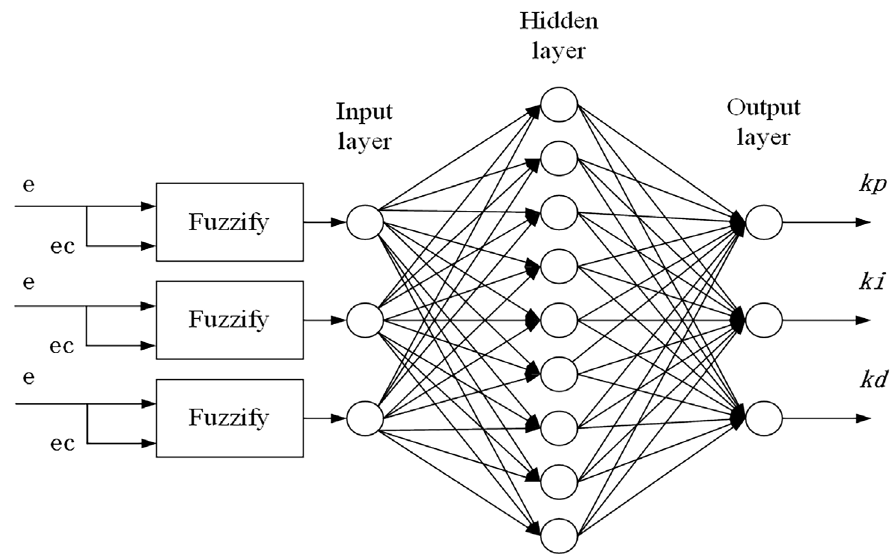
Figure 7. Fuzzy control surface diagram.